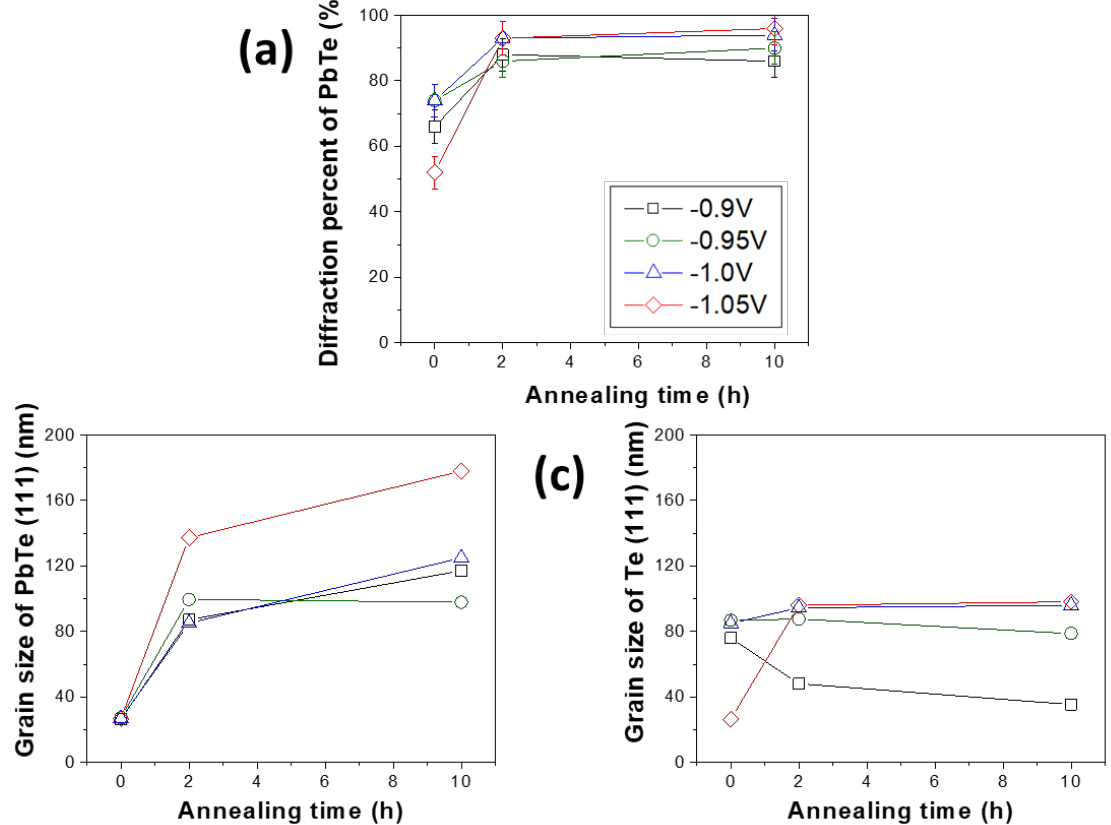
Figure 3. Diffraction percent ( a ) and grain size of PbTe ( b ), grain size of Te ( c ) as a function of annealing time (0, 2 and 10 h). The PbTe film electrodeposited at different applied potential: − 0.9, − 0.95, − 1.0 and − 1.05 V with 550 mM (TeO 32 − ), 100 mM (Pb 2+ ), and (EDTA 4 − )/(Pb 2+ ) of 7.5 at pH of 12.3 and temperature of 23 °C.